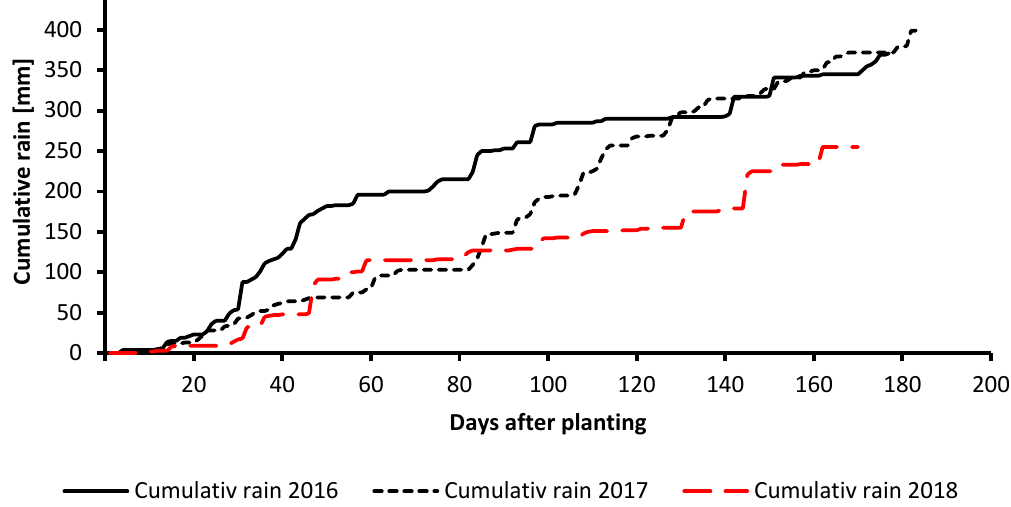
Figure 2. Cumulative rain (mm) observed at the weather station near to the sugar beet field experiment